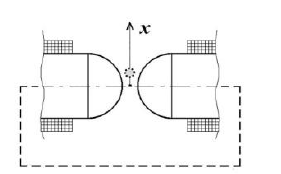
Fig.2. The variant of creation a working region (is located near the abscissa of the inflection of the coordinate characteristic of the magnetic field strength or induction and the abscissa of the extremum of the gradient, correspondingly) between the spherical pole pieces